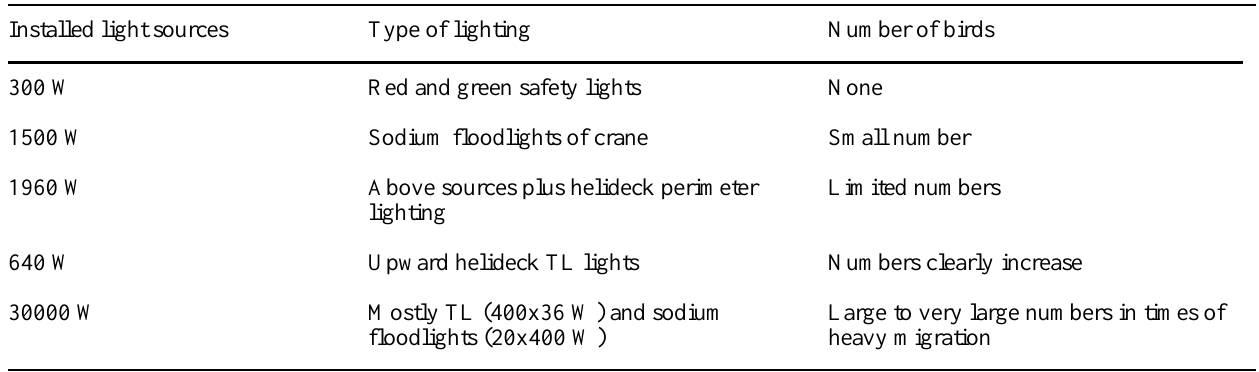
Table 2. Relationship between light intensity and the number of birds attracted to gas-production platform L5 (Marquenie and van de Laar 2004). Disconnecting different light groups varied light intensity: beacon and obstruction lights (300 W), light in crane (1500 W), helicopter platform (160 W), and landing lights (480 W). When all lights were on, total intensity was 30